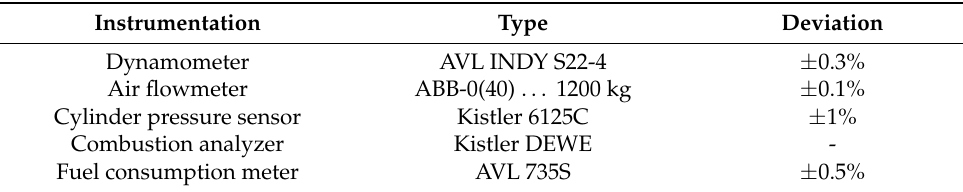
Table 2. Test bench instrumentations.